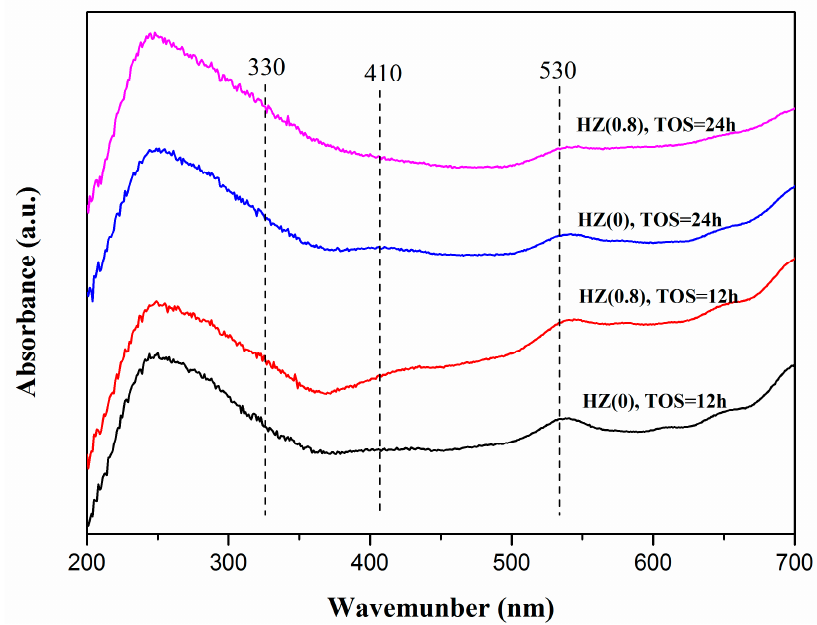
Figure 9. DR UV-vis spectra of the catalysts obtained in different TOS.